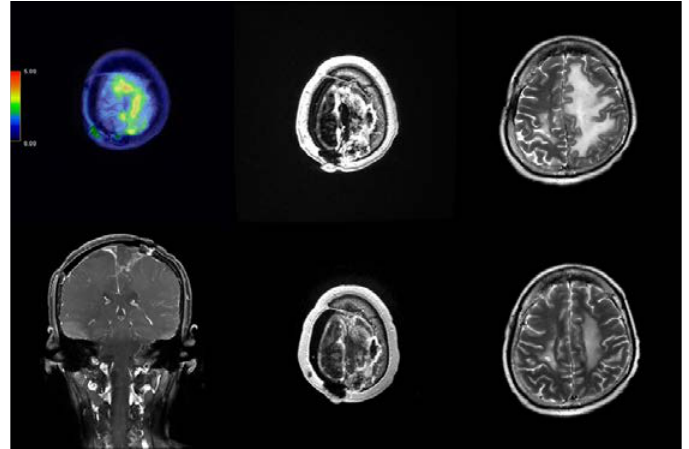
Figure 4. Images of case 197 with left high frontal meningioma. ( Upper left ) Pre-BNCT, FBPA-PET image, with tumor-to-normal tissue (TN) ratio around 2.64. ( Upper middle ) Pre-BNCT, axial MRI with contrast. ( Upper right ) Pre-BNCT, axial MRI T2 weighted image. ( Lower left ) Two months after BNCT, coronal MRI with contrast. ( Lower middle ) Two months after BNCT, axial MRI with contrast. ( Lower right ) Two months after BNCT, axial MRI T2 weighted image.